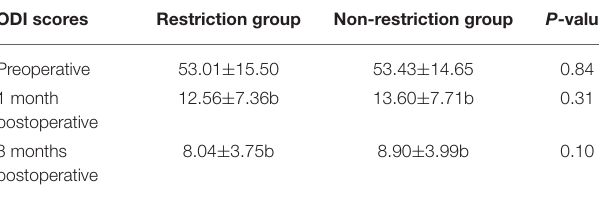
TABLE 3 | Comparison of the ODI scores. TABLE 4 | Comparison of recurrence